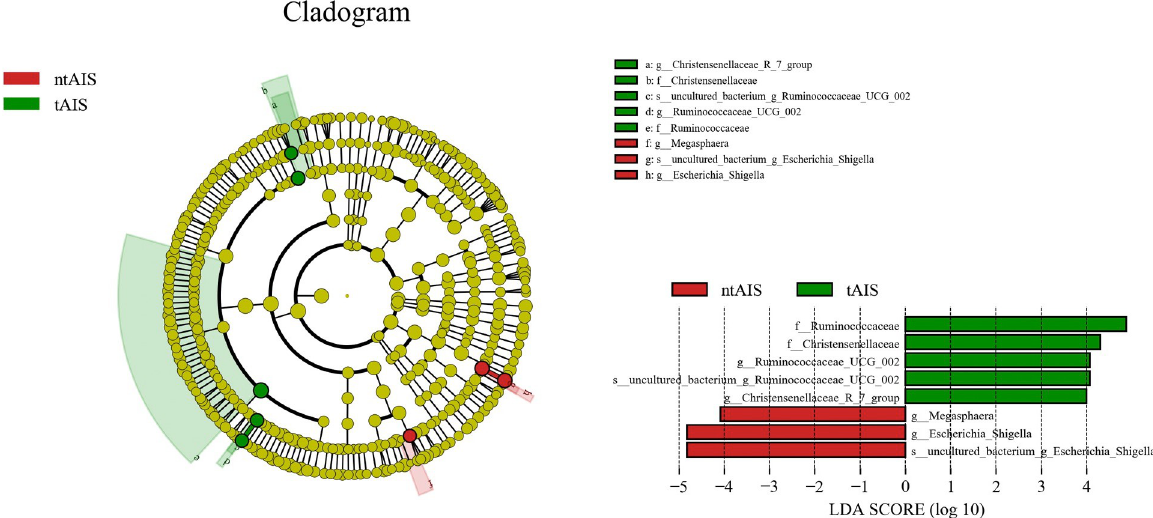
Fig 9. Levels differ significantly between ntAIS and tAIS groups by LEfSE analysis. AIS: Acute ischemic stroke, tAIS: Patients with PHS, ntAIS: Patients with non-PHS, tntAIS: A combination of patients with PHS and non-PHS, HC: Healthy controls. The LDA score was obtained by LDA (linear regression analysis); the larger the LDA score, the greater the influence of species abundance on the difference effect.